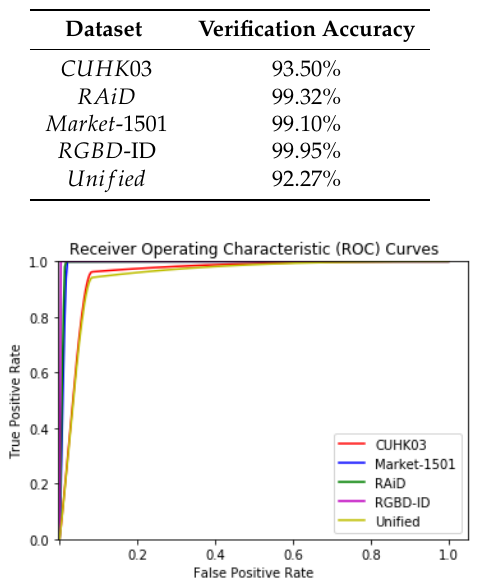
Figure 11. Receiver Operating Characteristic ( ROC ) curves per dataset as achieved by the Siamese network. Note that the green and blue color lines almost overlap.